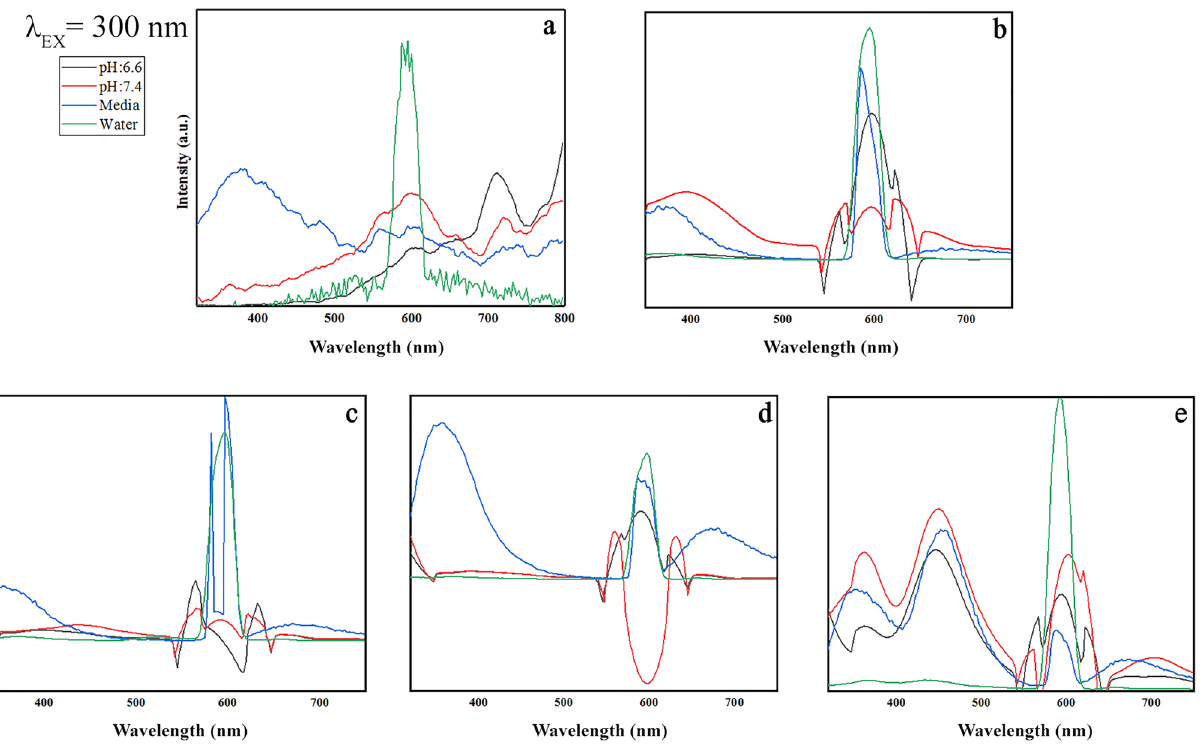
Figure 1. Emission patterns of ( a ) GO, ( b ) GO-PEG, ( c ) GO-PEG-Fe 3 O 4 , ( d ) GO-PEG-Au, and ( e ) GO-PEG-FA at the excitation wavelength of 300 nm in water, cell media (DMEM) and PBS, at two different pH values (pH 6.6 and 7.4).